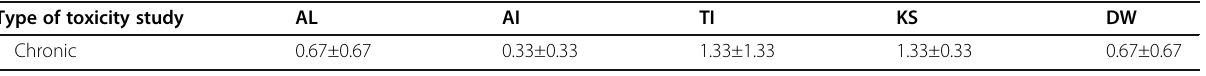
Table 6 Effects of prolonged oral administration of extracts of four ethnomedicinal in rats on blood parameters (Continued)